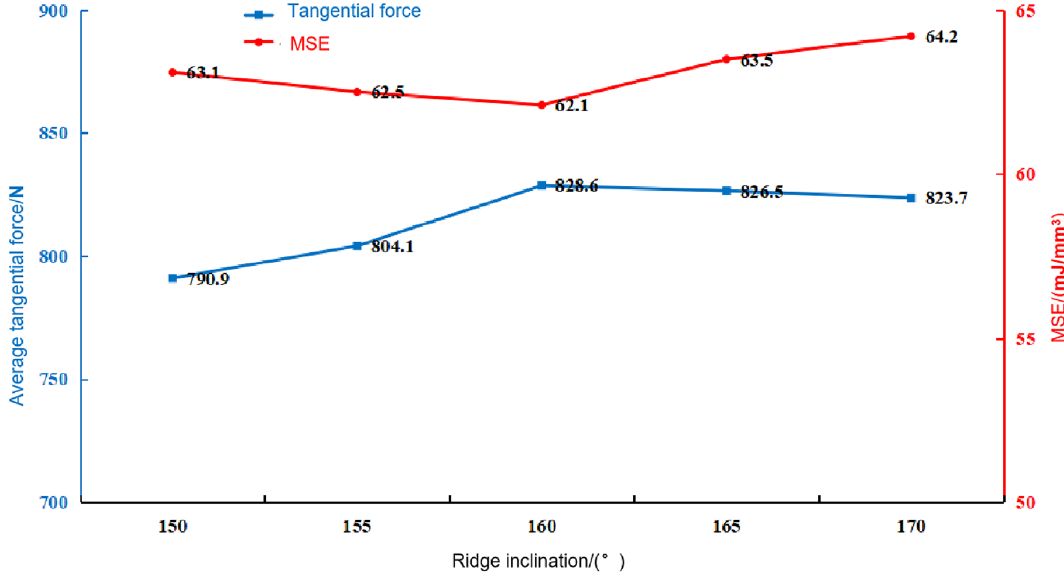
Fig. 8 Tangential force and MSE of cutters with different ridge inclination